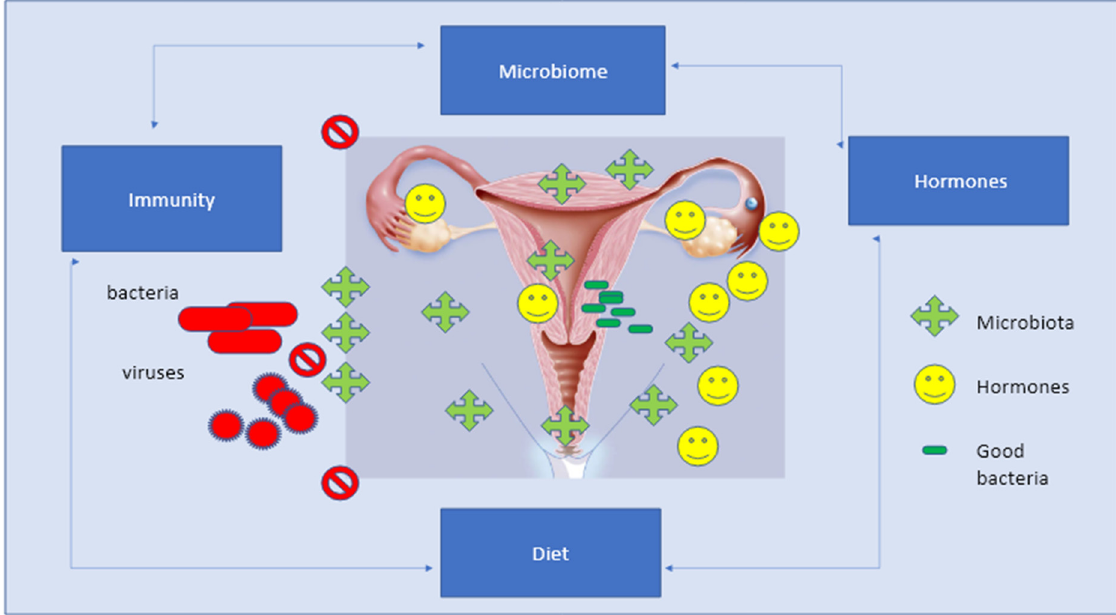
Figure 4. The Eubiosis of the female sex apparatus is based on the balance of several factors composed of microbiota, hormones, and local bacteria, which is then associated to regular and equilibrated immune responses, diet, and active life—style.